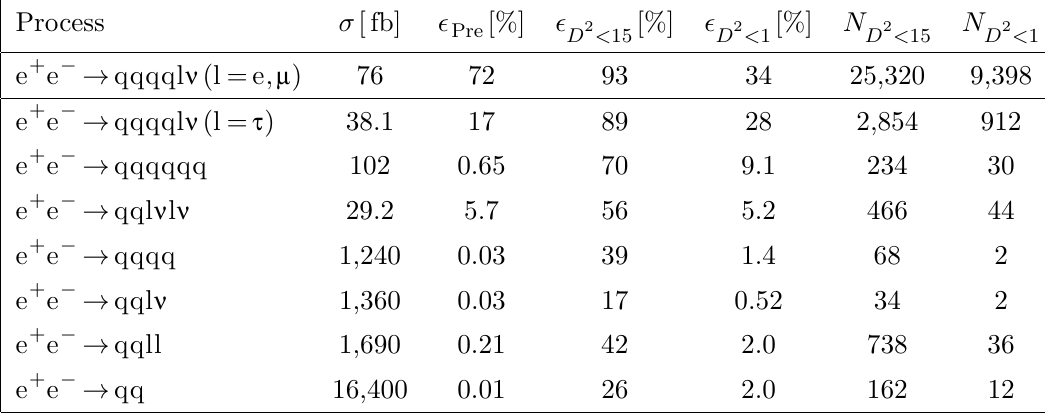
Table 8. Pre-selection and (cid:12)nal event selection e(cid:14)ciencies and expected number of events for the tt analysis of CLIC at a nominal collision energy of 380 GeV. The numbers are shown for P(e (cid:0) ) = +80% assuming 0 : 5 ab (cid:0) 1 .